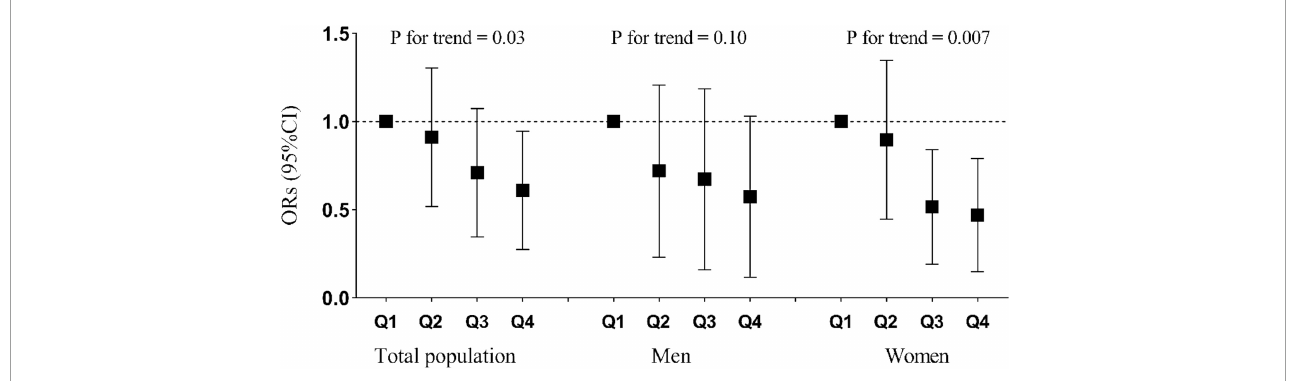
FIGURE2 Relationship between quartiles of riboflavin intake and prevalence of osteoporosis stratified by total population, men, and women. Adjusted for age, sex, BMI, smoking status, drinking status, physical activity, hypertension, diabetes, hyperlipidemia, self-rating depression scale score, energy intake, and calcium